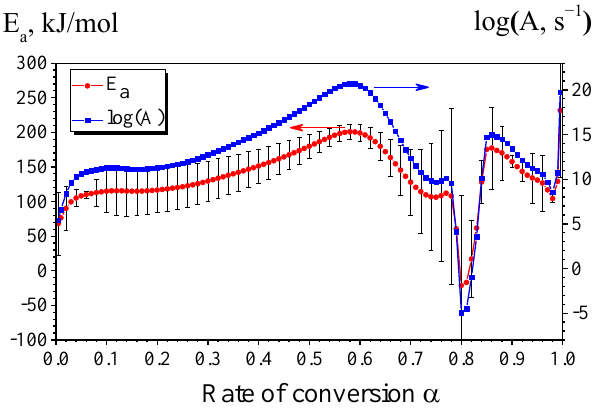
Figure 8. Friedman analysis of the DSC data for (Cu/a-Si) 30 . Table 6. Model-free estimation of the kinetic parameters of the solid-state transformation process in the Cu/a-Si thin films obtained using the DSC and electron diffraction